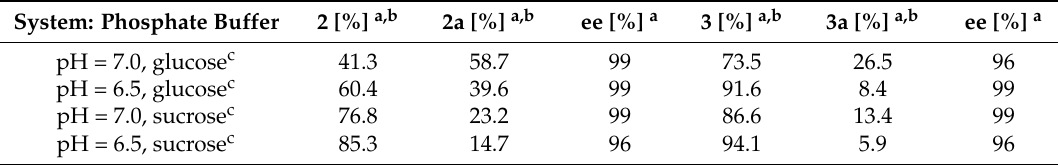
Table 2. Reduction of 2 and 3 by Aureobasidium pullulans in different conditions.